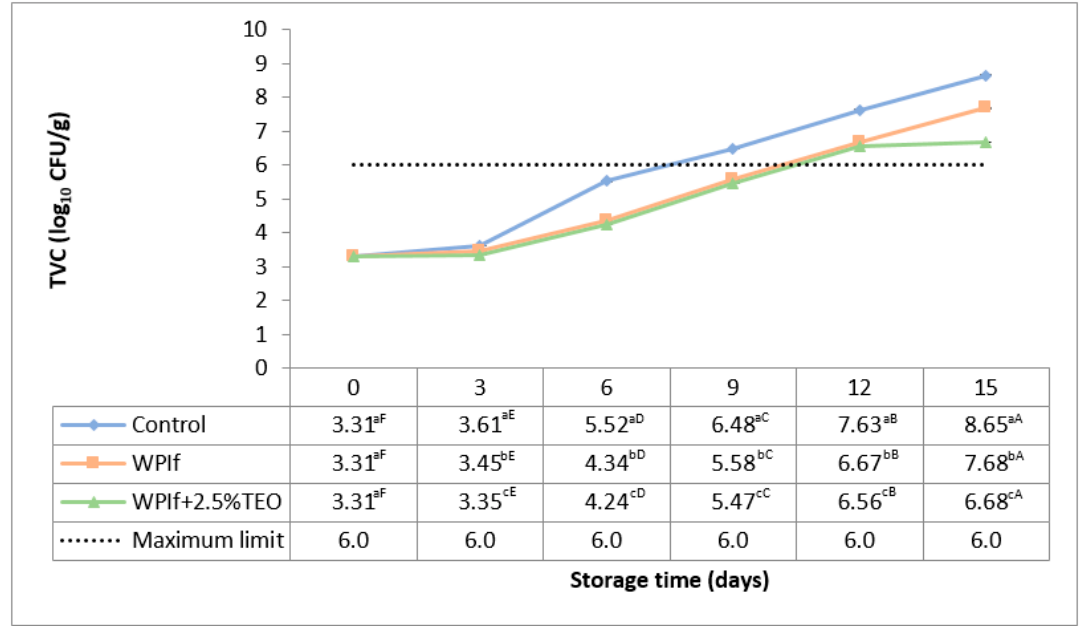
Figure 6. Changes in total viable count (TVC) of brook trout samples during refrigerated storage. Control-uncovered fish samples; WPIf-fish samples covered with WPI-based films; WPIf+2.5%TEO-fish samples covered with whey protein isolate-based films incorporated with 2.5% tarragon essential oil. Values are expressed as mean ± standard deviation of two replicates. Means that do not share a letter (lowercase letters on column and uppercase letters on row) are significantly different.